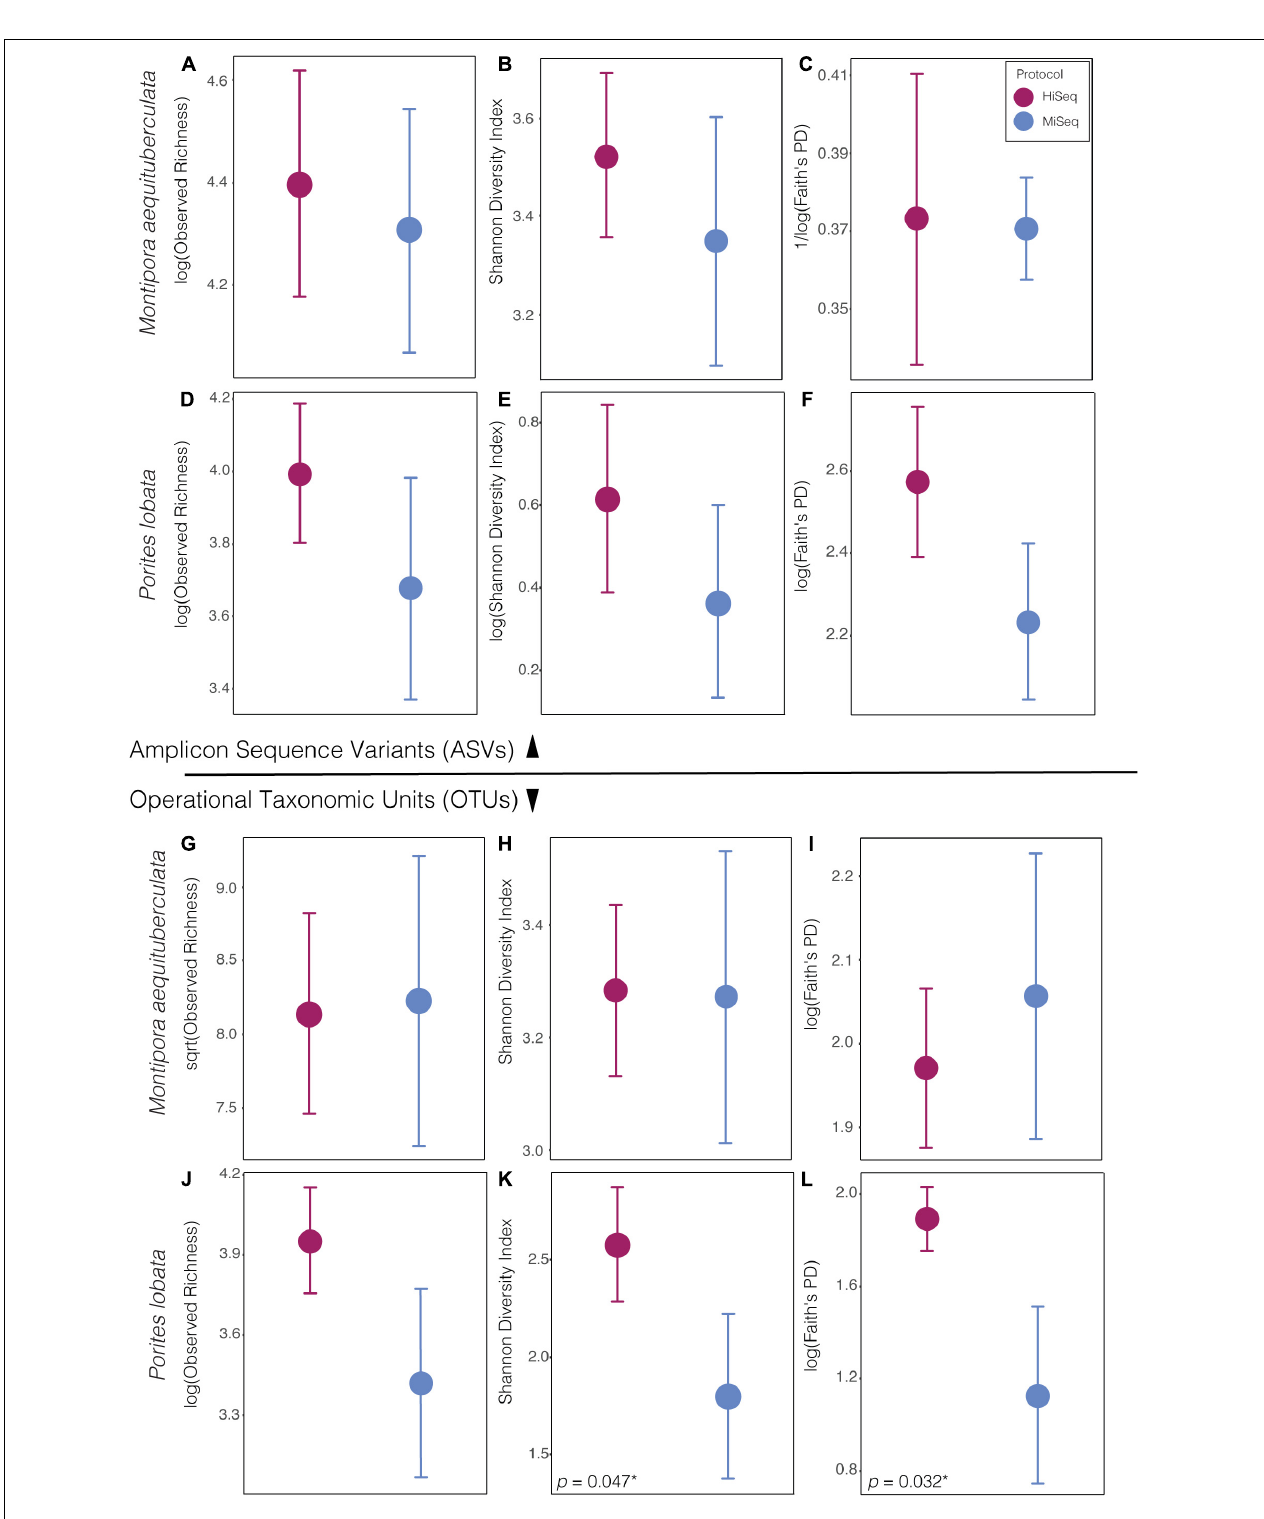
FIGURE 1 | Alpha diversity metrics of bacterial ASVs (top) and OTUs (bottom) between protocols in both species, Montipora aequituberculata (A–C and G–I) and Porites lobata (D–F and J–L) , for observed species richness (A,D and G,F) , Shannon diversity (B,E and H,K) , and Faith’s phylogenetic distance (C,F and I,L) [significant p-values are reported in lower left-hand corner of panel with an asterisk (*). For all other p-values, see Supplementary Table 2 ].